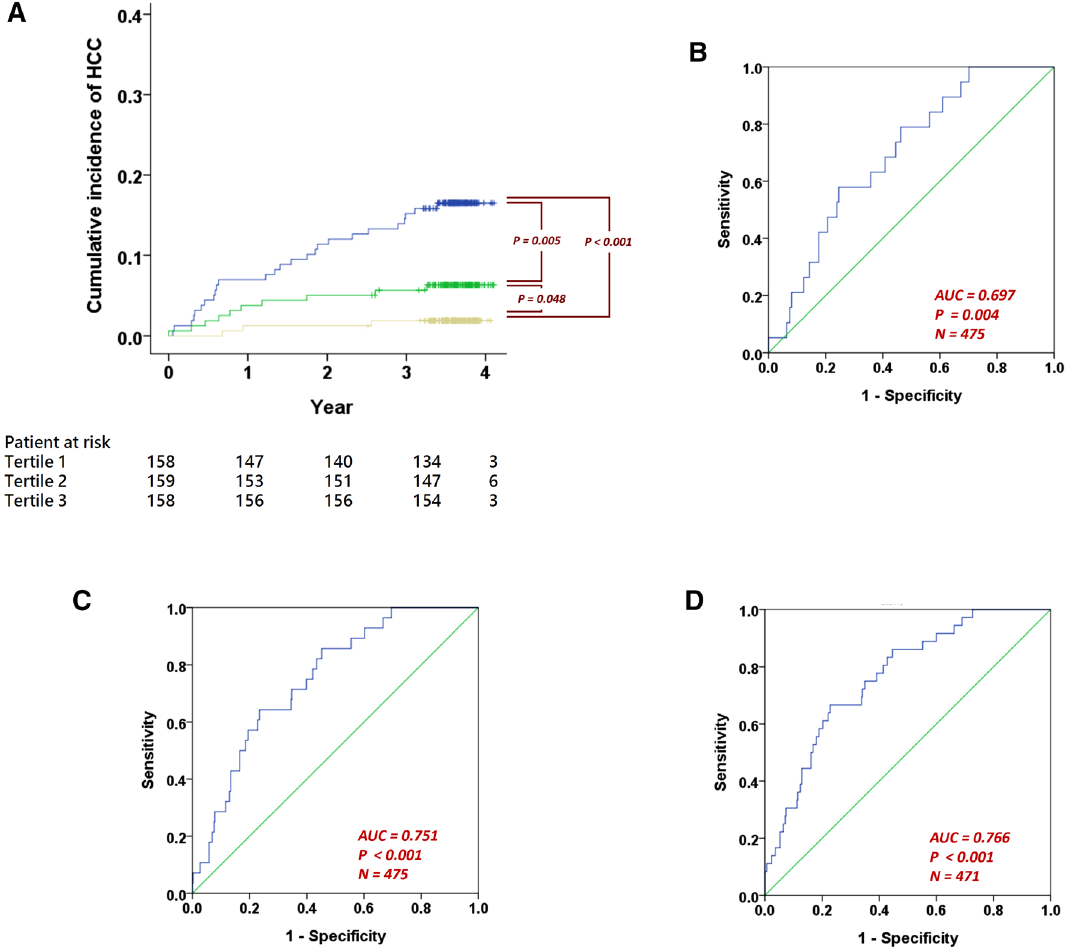
Figure 2. Risk score performance in time to event analysis and cross-sectional analysis. ( A ) The Kaplan–Meier plot of patients stratified into tertiles by the risk score (N = 475). ( B ) The receiver-operating-characteristic (ROC) curve of the risk score for classifying patients with or without HCC at 1 year after recruitment. The area under the ROC (AUC) is 0.697. ( C ) The ROC curve for classifying patients at 2 years after recruitment (AUC = 0.751). ( D ) The ROC curve for classifying patients at 3 years after recruitment (AUC = 0.766).